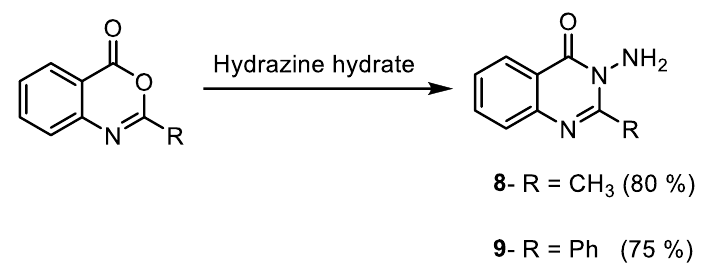
Scheme 2. Reaction scheme for the synthesis of the quinazolinone derivatives.